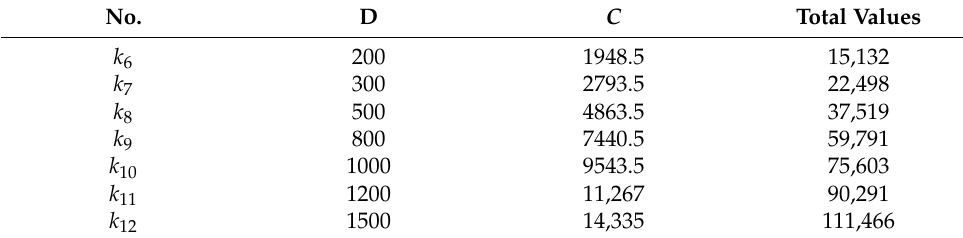
Table 2. Randomly generating seven 0–1 knapsack